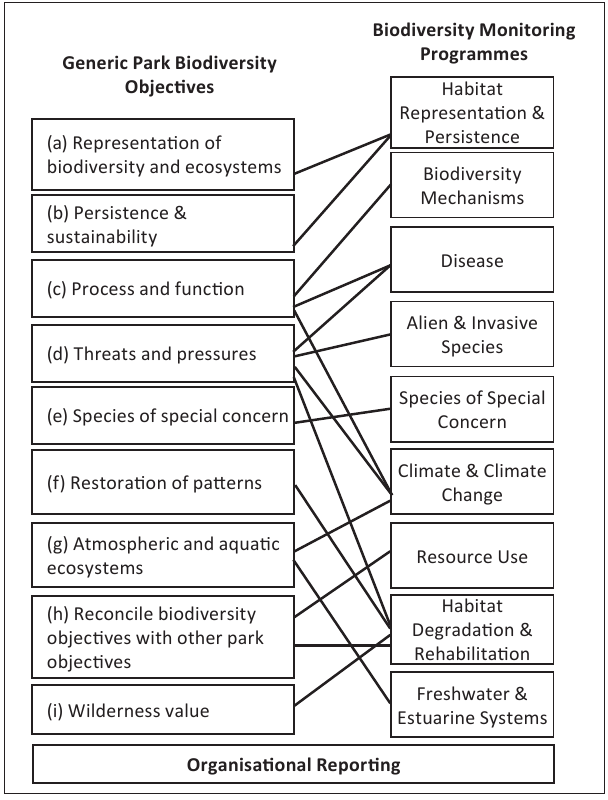
FIGURE 3: Relationship between biodiversity management objectives (left) and Biodiversity Monitoring Programmes